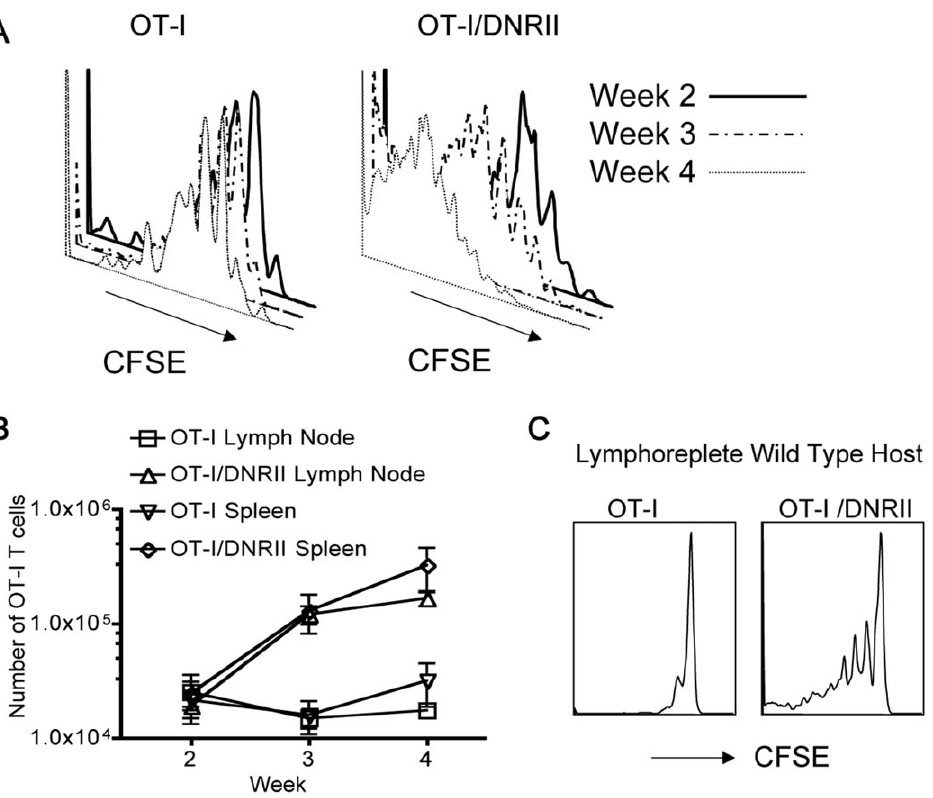
Figure 2. Extended expansion of OT-I/DNRII CD8 T cells as lymphopenic space becomes limiting. CFSE labeled CD44 lo OT-I and OT-I/ DNRII CD8 T cells were adoptively co-transferred into indicated B6 hosts. Host animals were sacrificed at the indicated timepoints for analysis of donor and host cells. (A, B) OT-I and OT-I/DNRII CD8 T cells were cotransfered into irradiated hosts and analyzed 2, 3 and 4 weeks later. (n=3 per group) (A) CFSE dye dilution is shown for OT-I cells (left panel), and OT-I/DNRII cells (right panel) CD8 T cells. differentiated by congenic markers. (B) OT-I and OT-I/DNRII CD8 T cell recovery in the lymph node and spleen over time (n=3 per group). Results are expressed as mean 6 SD. (C) CFSE dilution of OT-I and OT-I/DNRII CD8 T cells three weeks after co-transfer into unirradiated (lymphoreplete) B6 hosts. Kb-OVA tetramer pulldowns were used to enrich for OT-I and OT-I/DNRII CD8 T cells. All data are representative of at least 3 independent experiments.